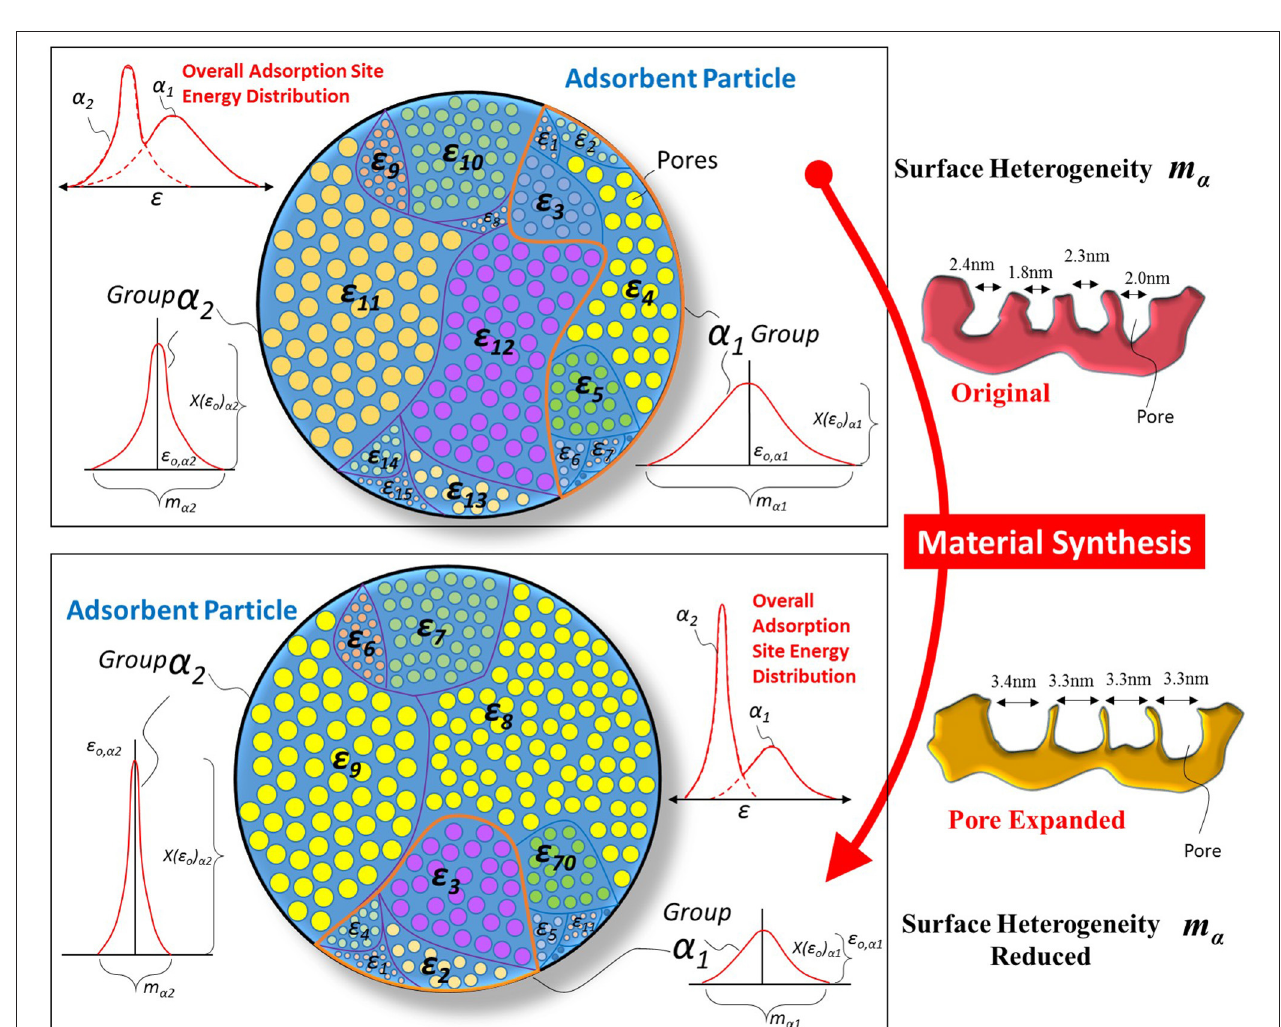
FIGURE 2 | Schematic of the porous adsorbent surface with the presence of adsorption energy sites distribution and possible change in it after material synthesis. The material synthesis caused the expansion of pores that resulted in a difference in the material’s topography. The surface heterogeneity of synthesized material is reduced as fractional availability X( ε ) of larger pores is higher when smaller pores were expanded and as a result, the overall spread “ m ” of energy distribution is reduced.